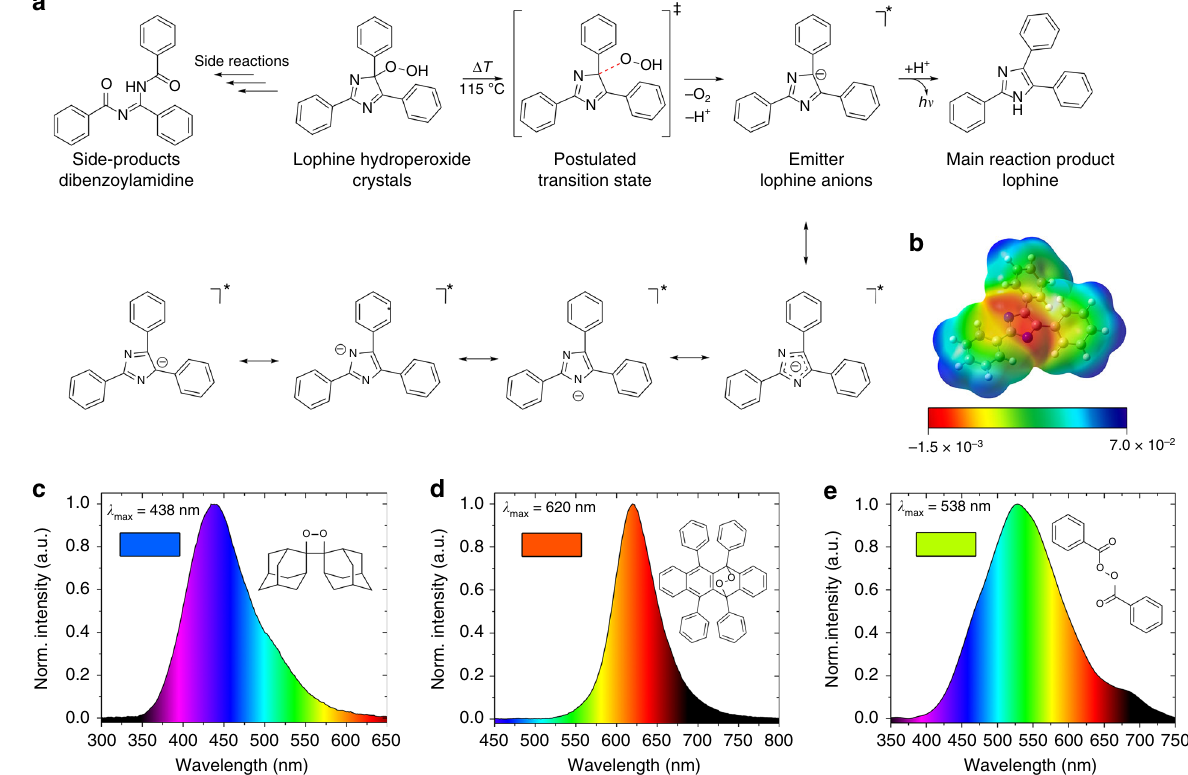
Fig. 4 Thermochemiluminesence and spectra of LHP and other peroxides. a Proposed reaction mechanism for the solid-state thermochemiluminescence of LHP. b Electrostatic potential isosurface of the lophine anion mapped onto its total density surface, showing delocalization of the negative charge across the central imidazole core. The color-coded scale is given on the bottom with the potential in relative units, increasing from red (most negative) to blue (most positive). c ‒ e Solid-state thermochemiluminescence spectra of other organic peroxides selected as representative members of different peroxide classes: bis (adamantly)-1,2-dioxetane (1,2-dioxetane) ( c ), rubrene endoperoxide (endoperoxide) ( d ), and benzoyl peroxide (aroyl peroxide) ( e